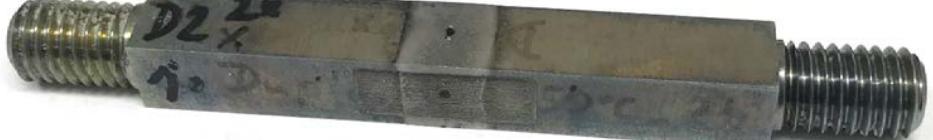
Figure 3. Example of the sample used for the physical simulation of the welding process (the figure shows a sample after the application of the temperature cycle of 1386 ◦ C).